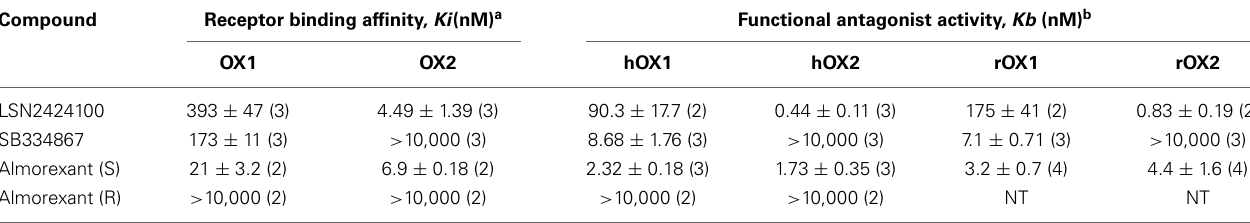
Table 1 | In vitro binding and functional activity at human recombinant OX1 and OX2 receptors. Compound